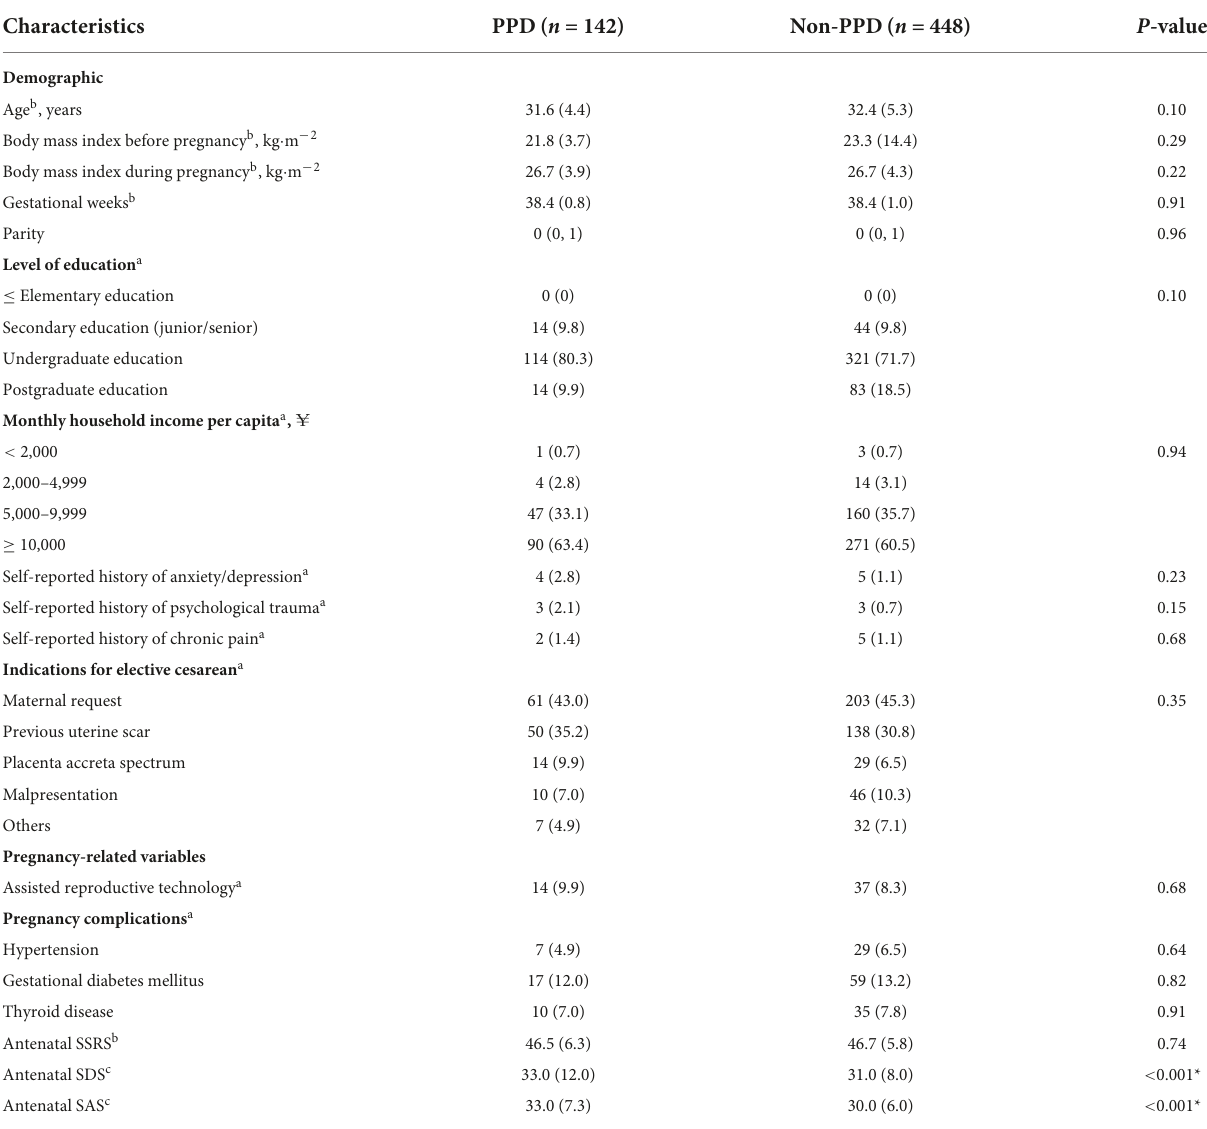
TABLE 1 Demographic and pregnancy-related characteristics among women included in the study.